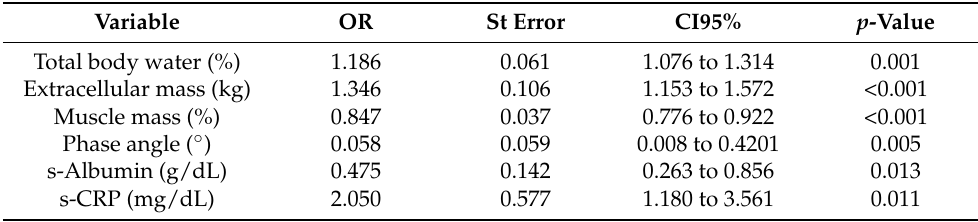
Table 4. Multivariate conditional regression analysis in cases and